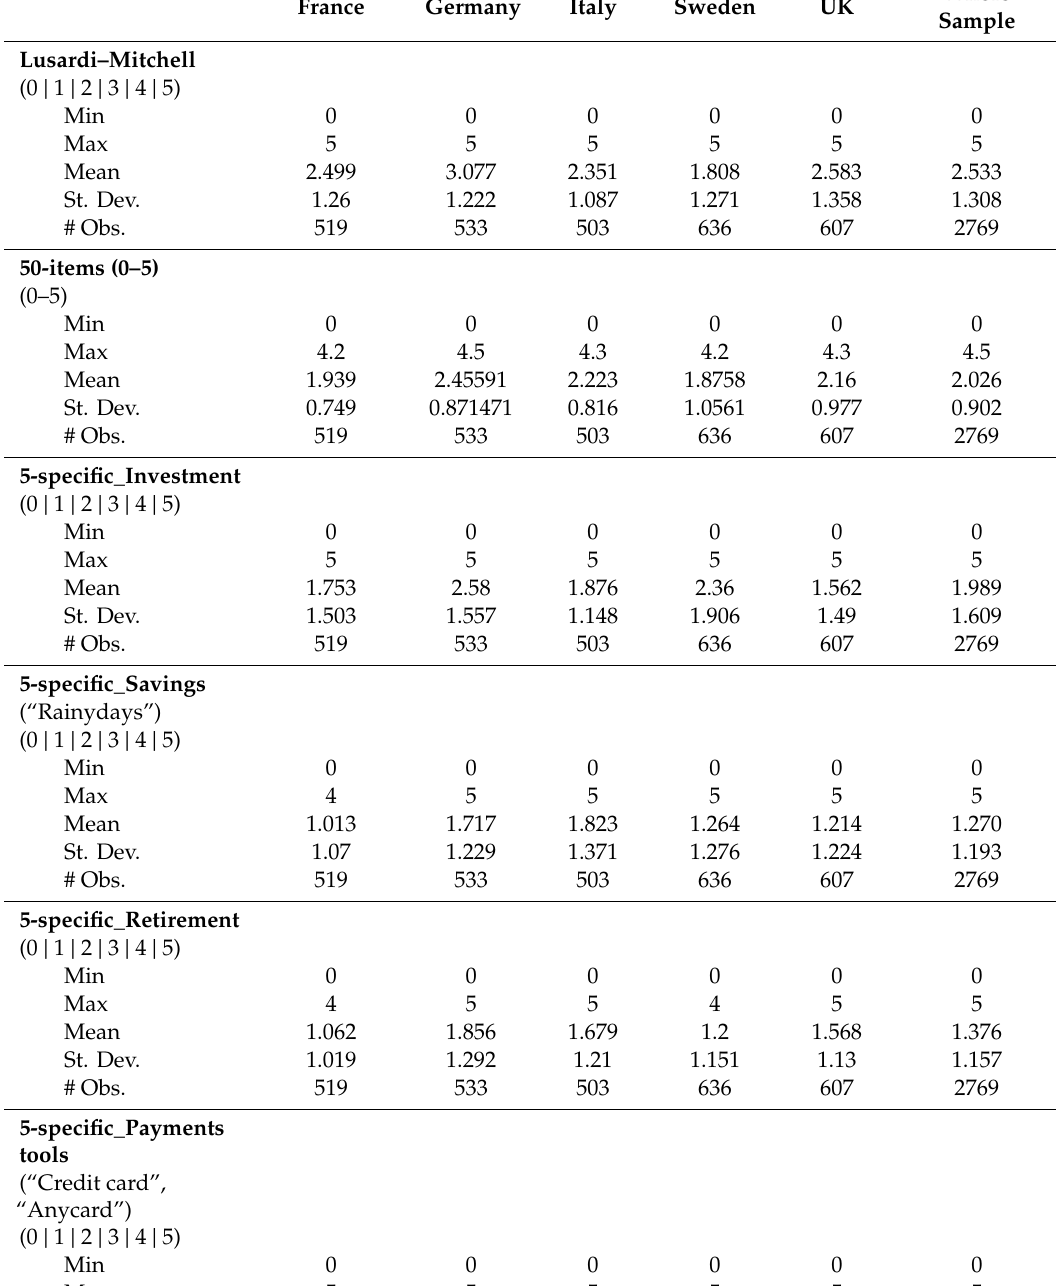
Table A3. Descriptive statistics of the financial literacy